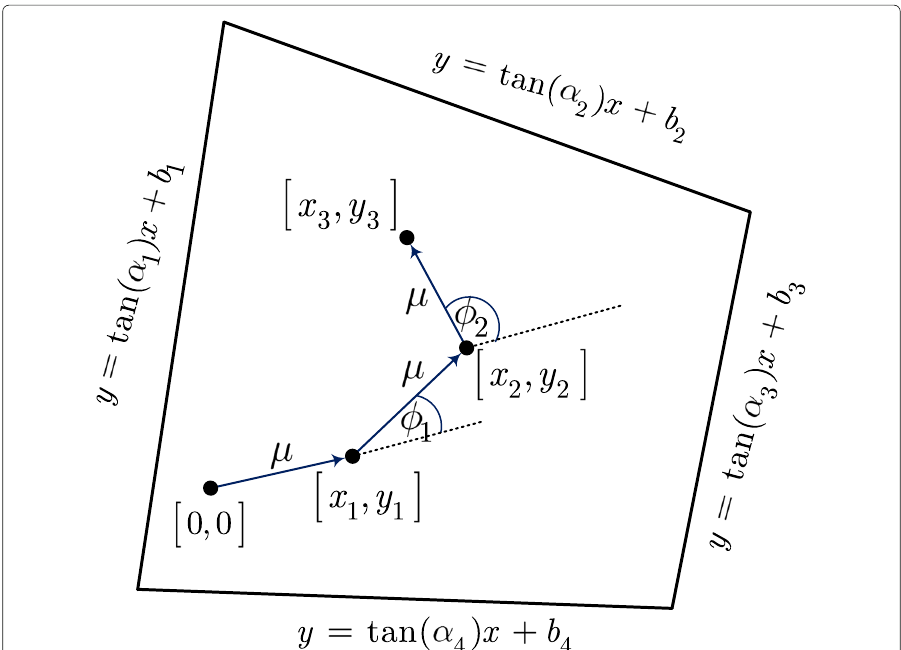
Fig. 1 Room geometry and robot location at time instant k = 1,2,3. Since the source and microphone are co-located in the x - y plane, it is impossible to discriminate between rotation and shifted versions of the room. To solve this, we set the initial robot location as the origin of the coordinate system ( 0,0 ) , while the first robot step defines the orientation of the coordinate system. The robot moves at a constant step size μ and an orientation angle φ k for each